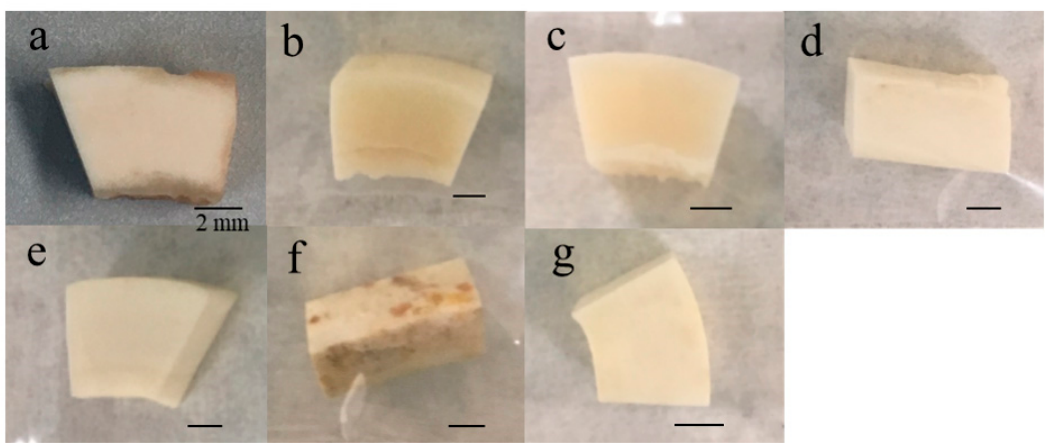
Figure 1. Bone samples maintained under five environmental conditions for 1 year: ( a ) control, ( b ) seawater, ( c ) freshwater, ( d ) outdoors, ( e ) indoors, and ( f,g ) underground.